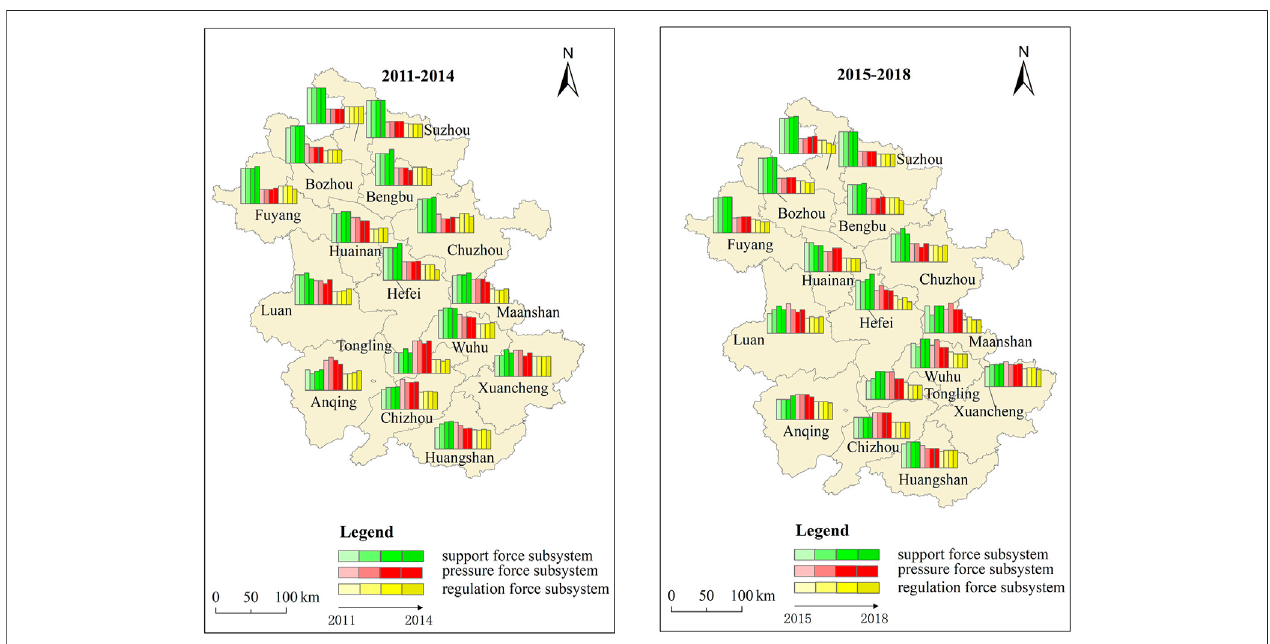
FIGURE 5 | Dynamic weights of the